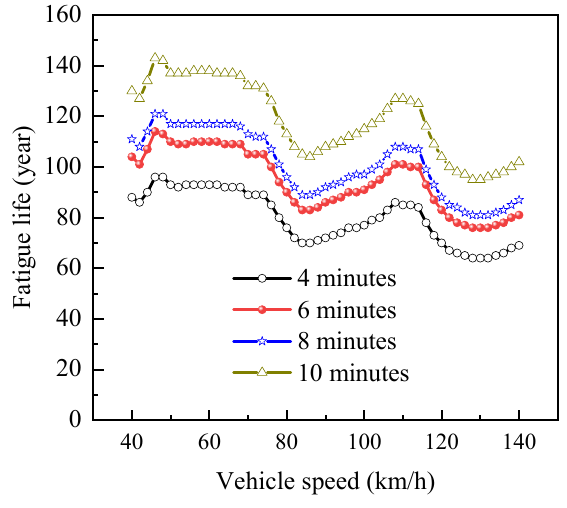
Figure 11. Fatigue of 30 m bridge under various vehicle speed.